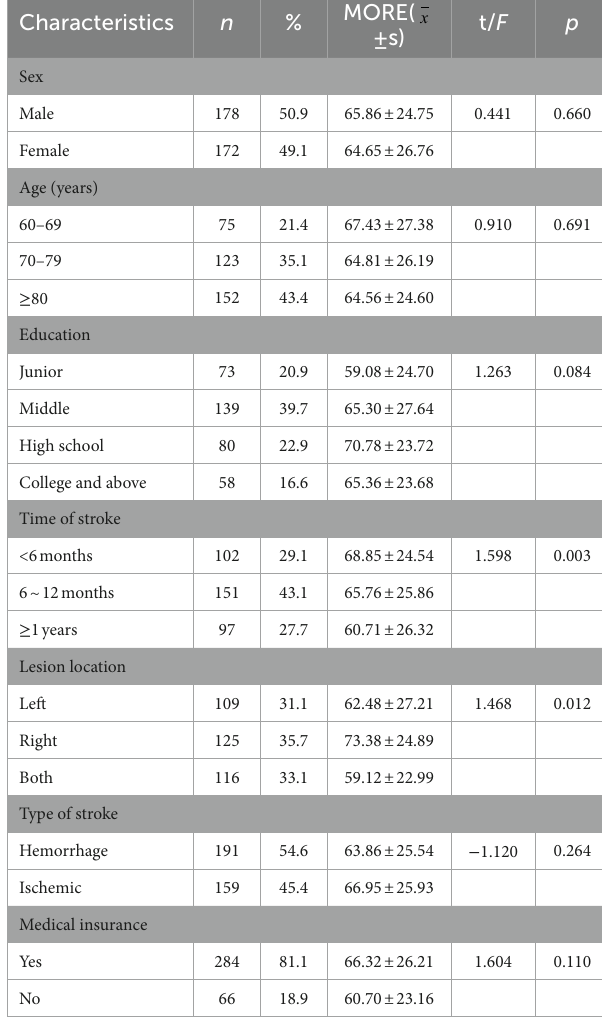
TABLE 1 General demographic information and ANOVA or t -test analysis of motivation for rehabilitation ( n = 350).